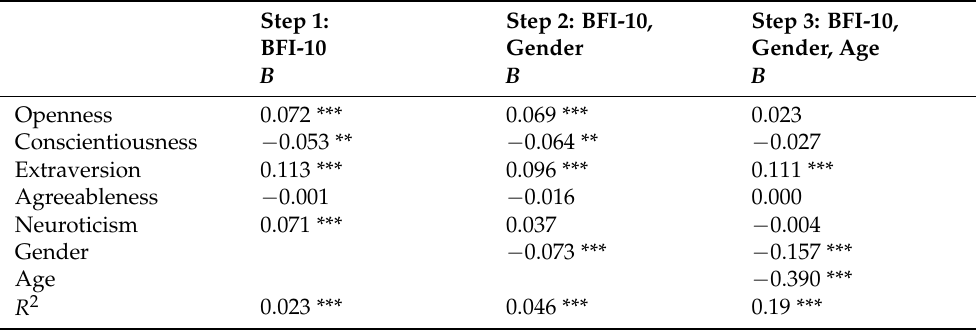
Table 6. Hierarchical regression model exploring how personality factors (BFI-10, 2019, 2020), gender, and age predict social media